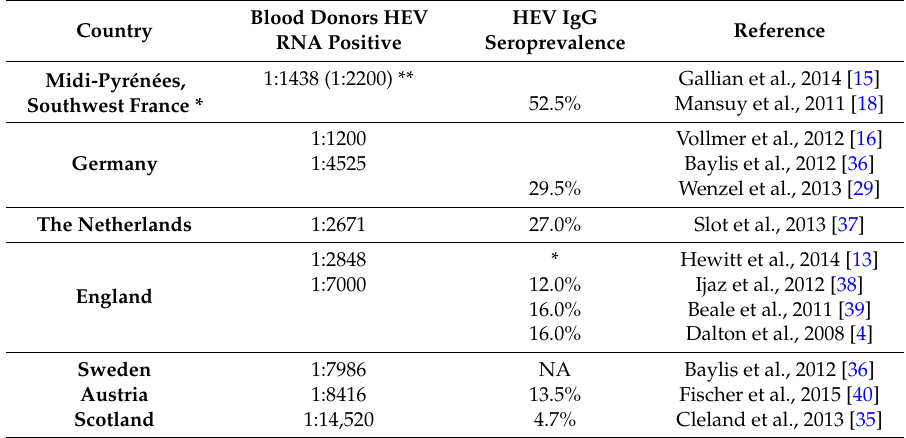
Table 4. HEV viremia and seroprevalence in blood donors in European countries.